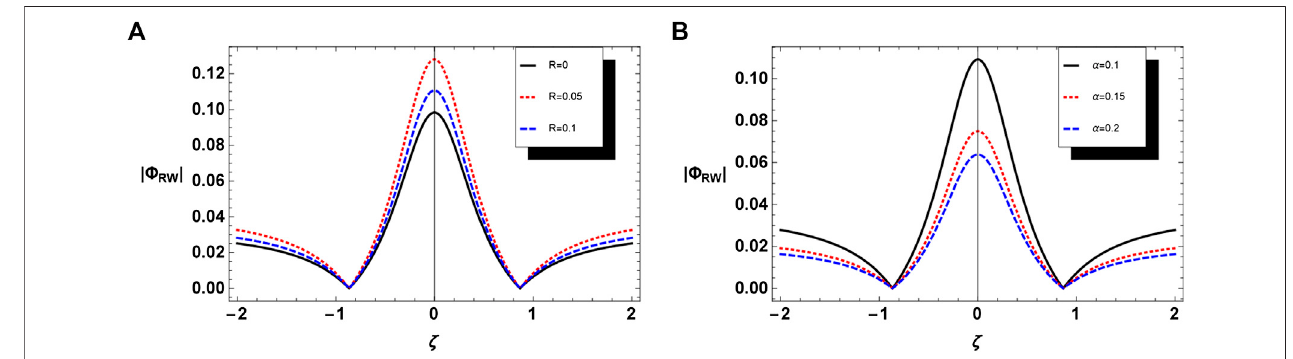
FIGURE 2 | The variation of DARW portrait with respect to ζ (A) for different values of R and (B) for different values of α at fi xed values of σ (cid:1) 0 . 01 and ρ (cid:1) 1 . 11.